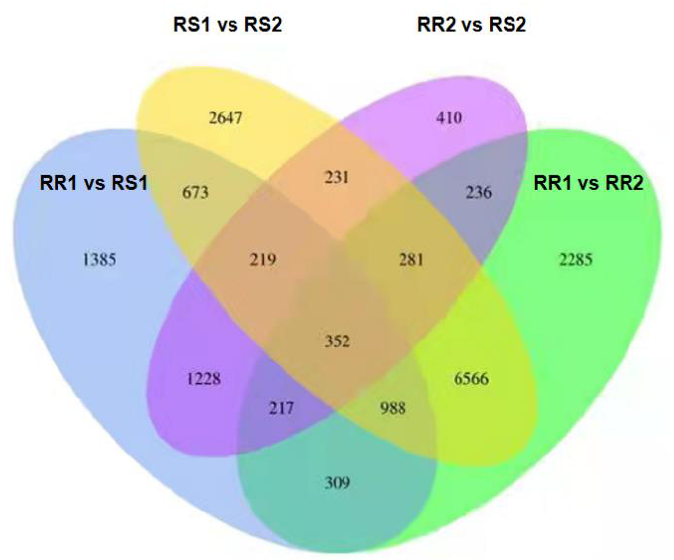
Figure 9. Venn diagram of differentially expressed genes in rust-resistant (RR) and rust-susceptible (RS) Z. japonica lines. RR1, RR without inoculation; RS1, RS without inoculation; RR2, RR inoculated for 5 days; RS2, RS inoculated for 5 days.